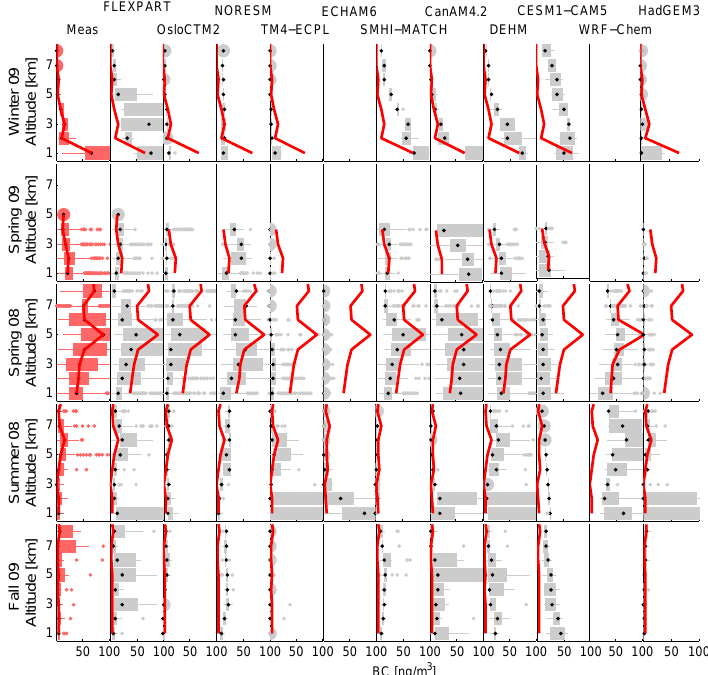
Figure 9. Comparison of modeled BC with observed rBC mass concentrations as a function of altitude for all data taken north of 70 ◦ N for the different campaigns (same as in Fig. 8). The leftmost column shows box and whisker plots of observed rBC concentrations in ngm − 3 . The black dots as well as the red lines represent the median values. The other columns show the modeled BC concentrations for FLEXPART, OsloCTM2, NorESM, TM4-ECPL, ECHAM6-HAM2, SMHI-MATCH, CanAM4.2, DEHM, CESM1-CAM5.2, WRF-Chem and